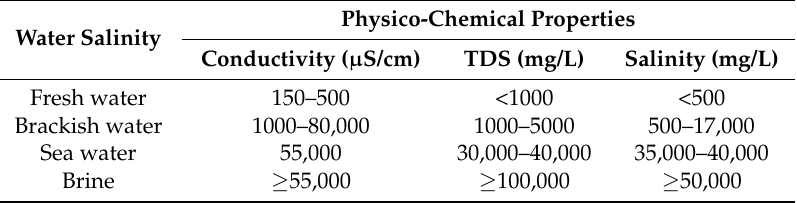
Table 3. The conductivity, TDS, and salinity of fresh, brackish and seawater [6,31–33].